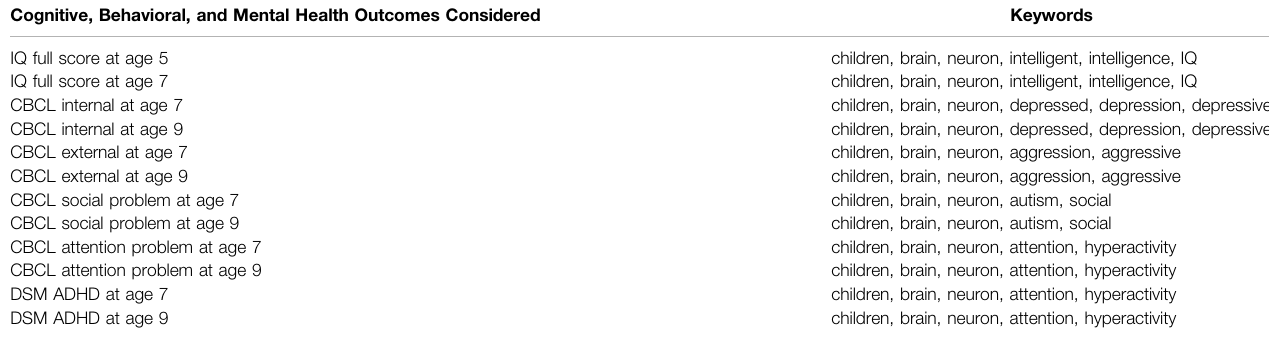
Step 3 : For each outcome, we tested associations between each of the environmental exposures and each of the signi fi cant CpGs identi fi ed in Step 2, adjusting for children ’ s sex and ethnicity ( Eq. 3 , where X j is the j th is the M-value residual of the k th CpG). exposure, CpG k For each outcome, we used FDR to adjust for multiple comparisons (number of test = number of exposure *